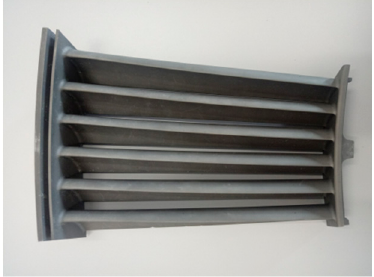
Figure 3. Integral steering apparatus.